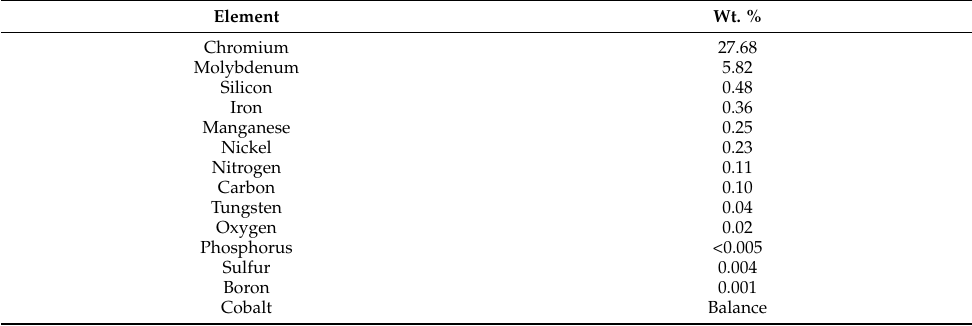
Table 1. Chemical composition of Co-Cr-Mo